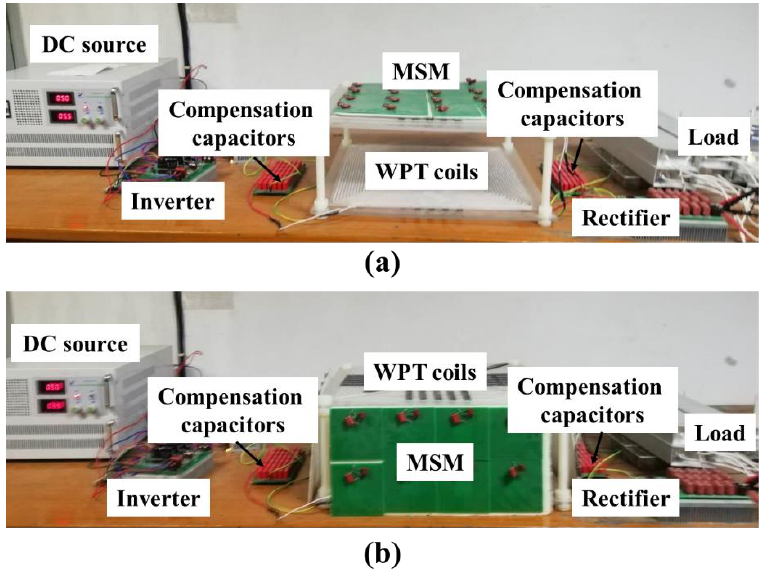
Figure 7. Measurement setup for the EV system: ( a ) MSM on the top, ( b ) MSM on the side of the EV.